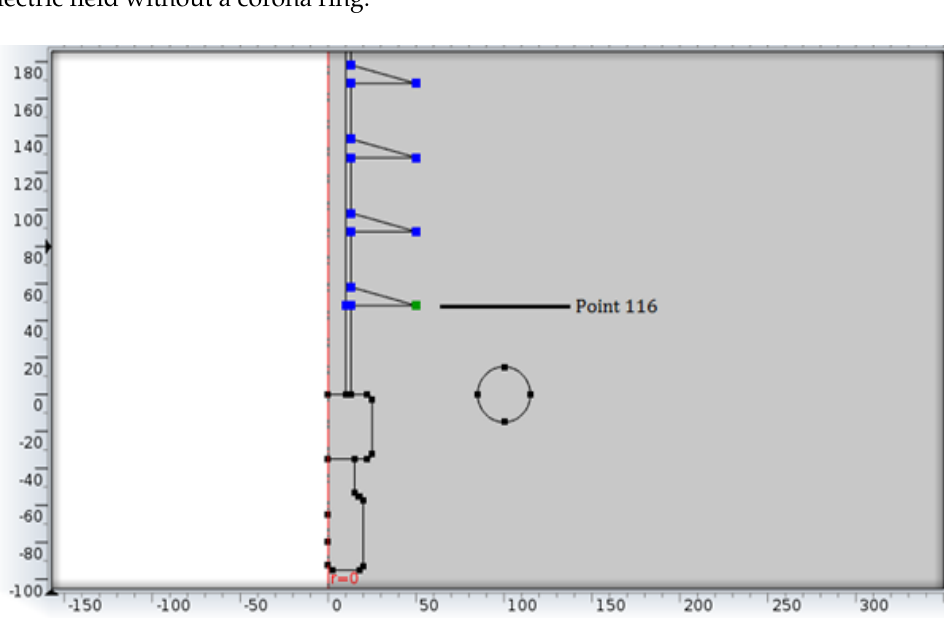
Figure 8. Selected point along the insulator.